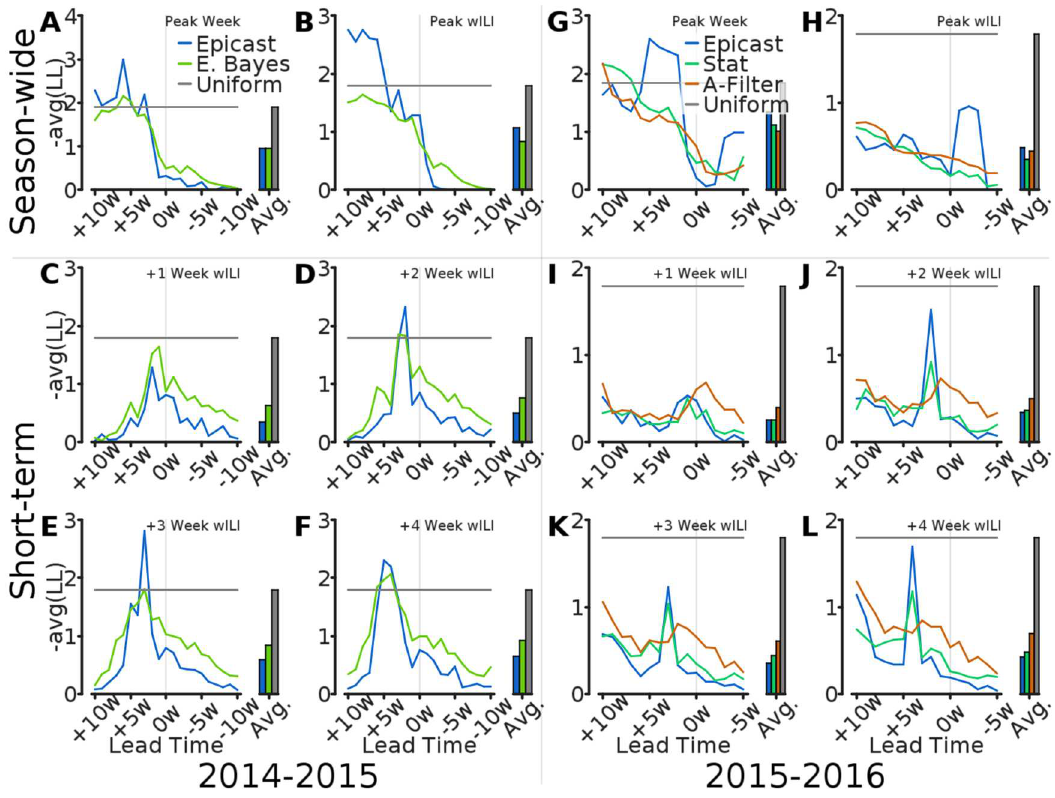
Fig 7. Comparison of log score by lead time. Log score, averagedacross regions( n = 11), is plotted as a function of lead time for of Epicast, Empirical Bayes (E. Bayes), Stat, ArcheFilter (A-Filter), and Uniform. Log score averagedover lead times is shown for each method on the right side of each subplot. Subplots show log score by (A; G) Peak Week, (B; H) Peak Height, and (C–F; I–L) wILI at 1, 2, 3, and 4 weeks ahead,